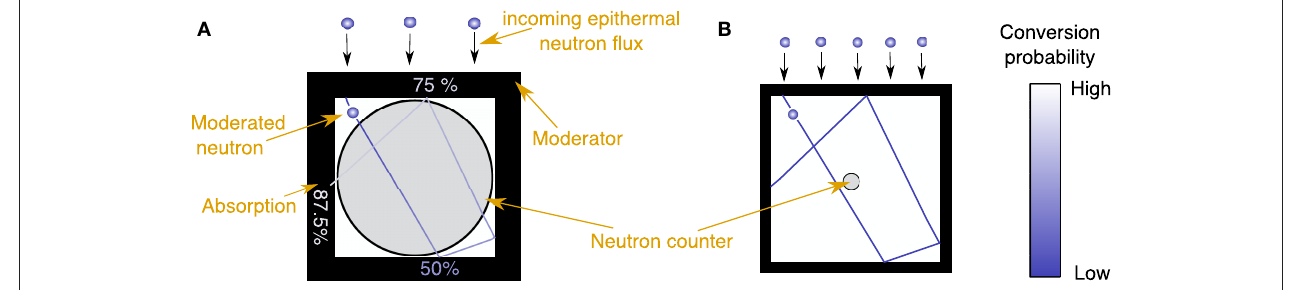
FIGURE 5 | Schematic drawing of the interplay between surface area and response function. The cross sections through two combinations of a rectangular moderator and cylindrical neutron counter at thermal efficiency of 50% are shown. Both figures are not to scale. A typical neutron track after thermalization through the inside of the moderator is shown in blue with the color saturation indicating the absorption probability by the converter material. (A) Maximizes the response function but features the smallest surface area possible, while (B) has a large surface area compared to the neutron counter dimension. Configuration (B) therefore has a large neutron flux impinging the moderator but a low response function because of the lower probability for a counter